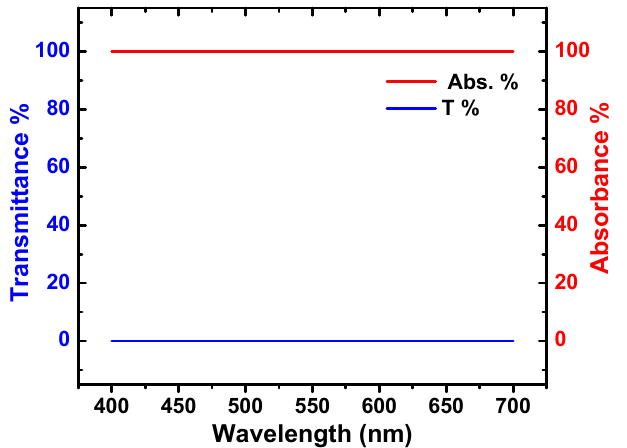
Figure 13. Transmittance % and absorbance % vs. wavelength for the matte black paint in the visible